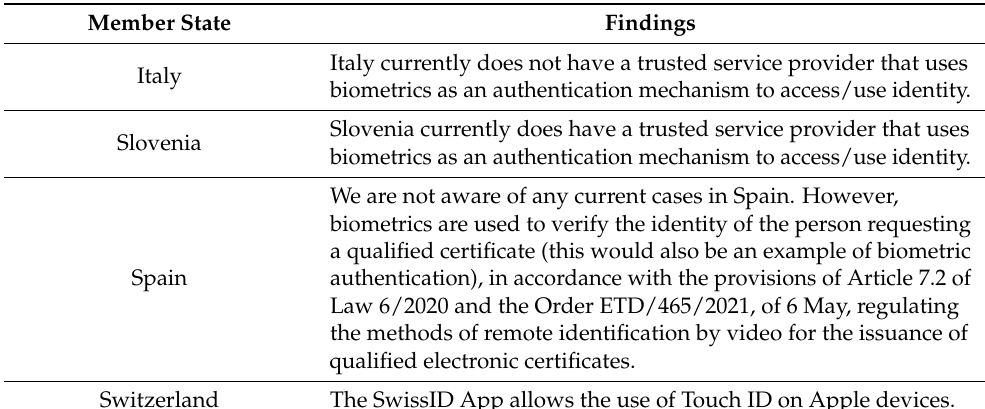
Table 6. Biometrics as an authentication mechanism for the sampled countries. Member